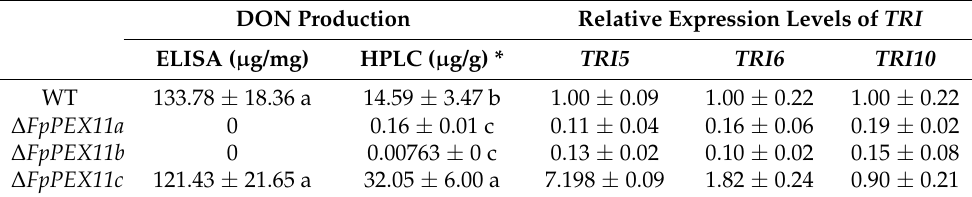
Table 2. DON production in the WT and ∆ FpPEX11